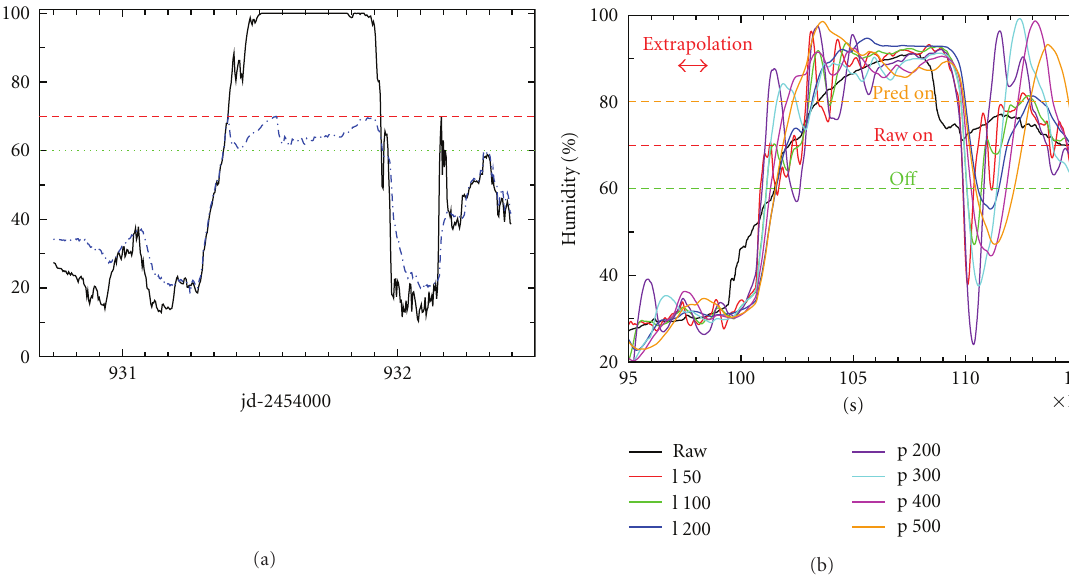
Figure 3: (a) The response of the environment system to the outside humidity (thick line). When a level of 70% on the rising edge is passed, the roofs are closed (note that the bay humidity, dot-dashed, stays roughly constant thereafter. Reopening of the building is allowed, once the humidity has dropped below 60% and remained at that level for at least two hours. (b) Prediction of inversion layer breakdowns. The thick line is the measured relative humidity. The 100-second extrapolations of various extrapolators are superimposed onto the true measurement. The true development of the humidity could be foreseen by all of the extrapolators. Note the delayed onset of the humidity rise of the extrapolated to the true values. The extrapolation could not predict that a sharp rise will start to occur, but the goal to predict the height of the humidity rise is well matched.